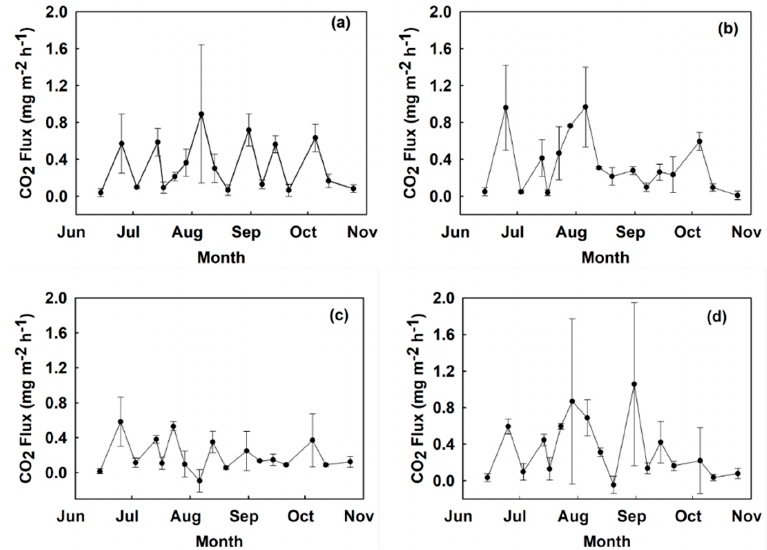
Figure 2. Time series CO 2 fluxes measured from June to October 2018 at site A in mg m − 2 h − 1 by treatment: ( a ) control, ( b ) digestate, ( c ) hydrochar, ( d ) urea. Values show a mean across two replicated plots with error bars representing the standard error.